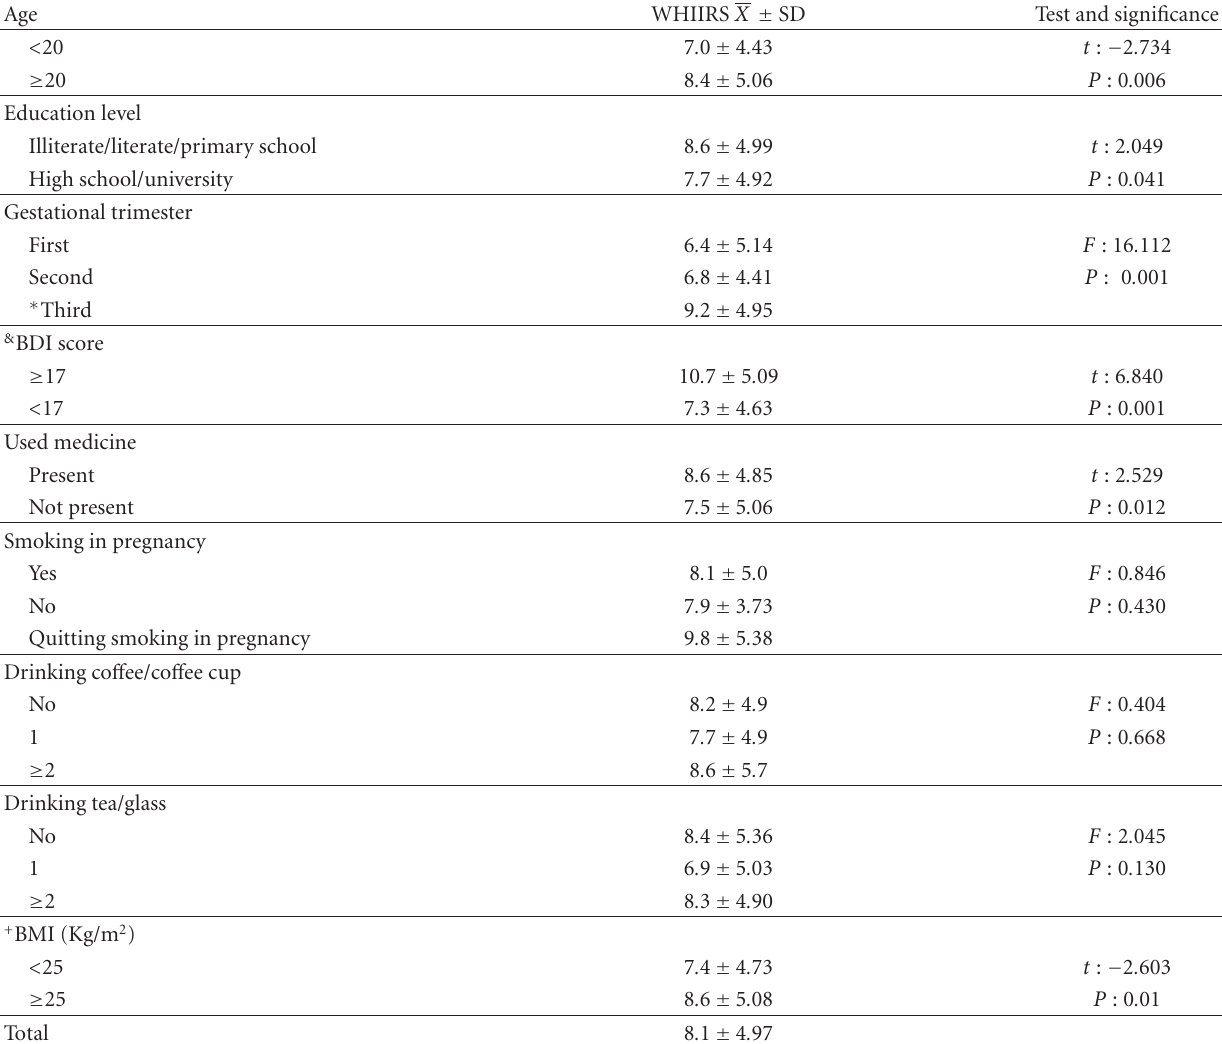
Table 3: The distribution of Women’s Health Initiative Insomnia scale scores according to some characteristics of the